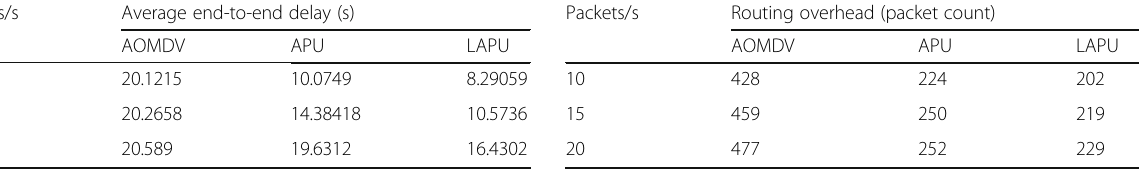
Table 2 Average end-to-end delay vs. data rate